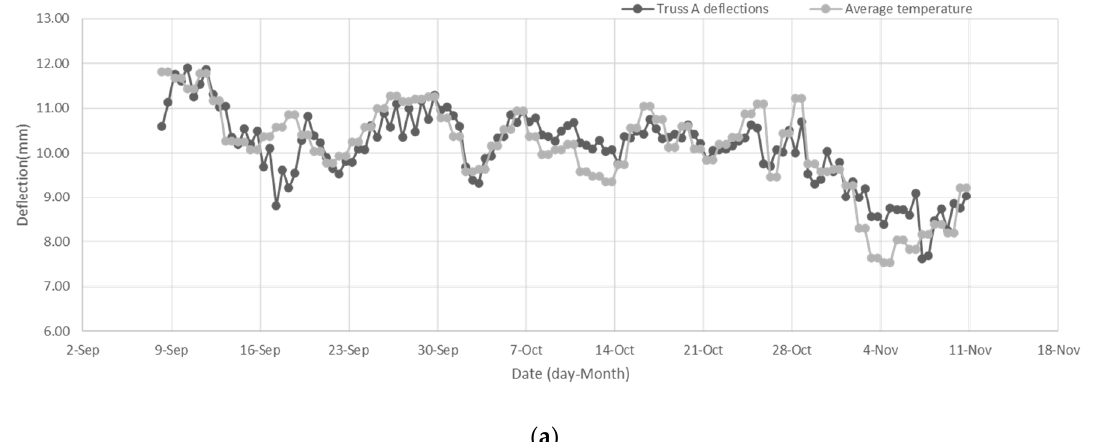
Figure 8. Correlation coefficient between deflection values and the environmental parameters.